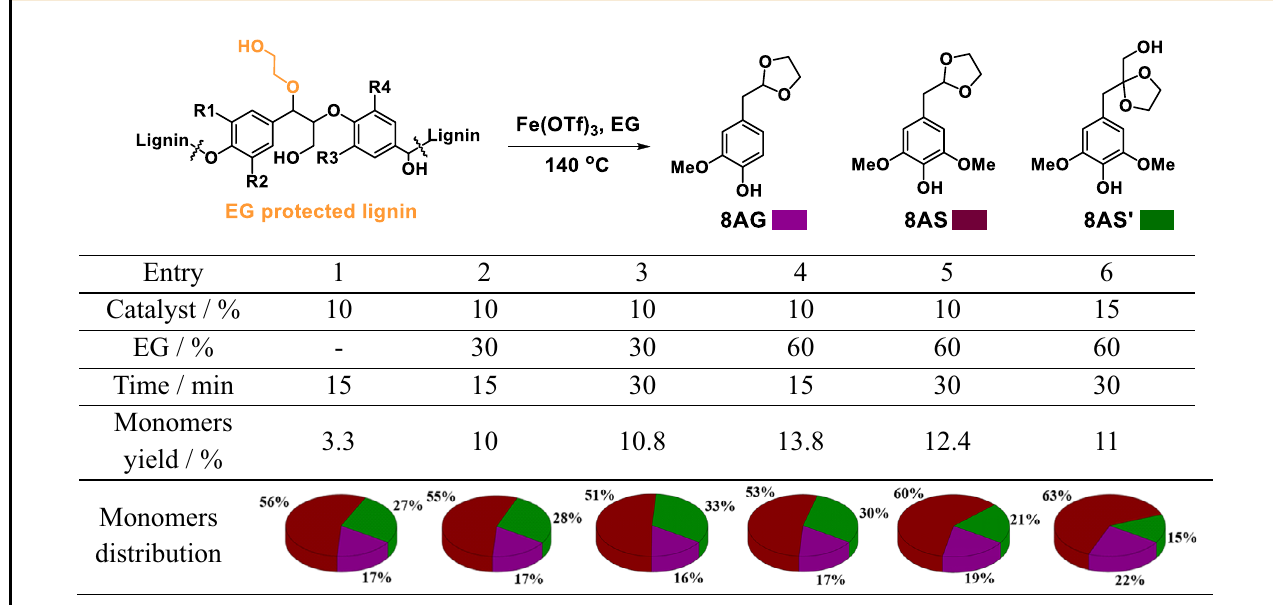
Table 3 Monomers yield and distribution of acidolysis